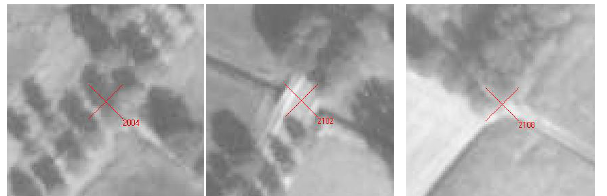
Figure 9: Not optimal ground control